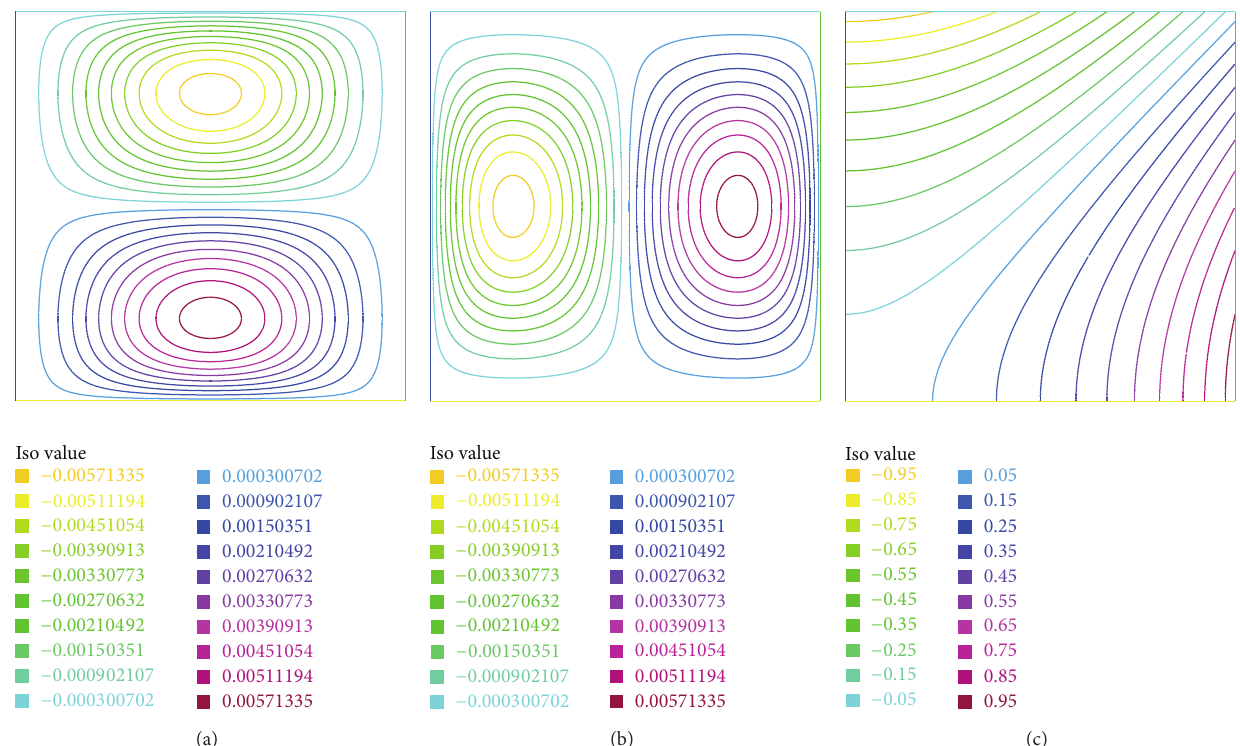
Figure 1: Contour plots of exact solution. From left to right: two components of velocity and pressure.